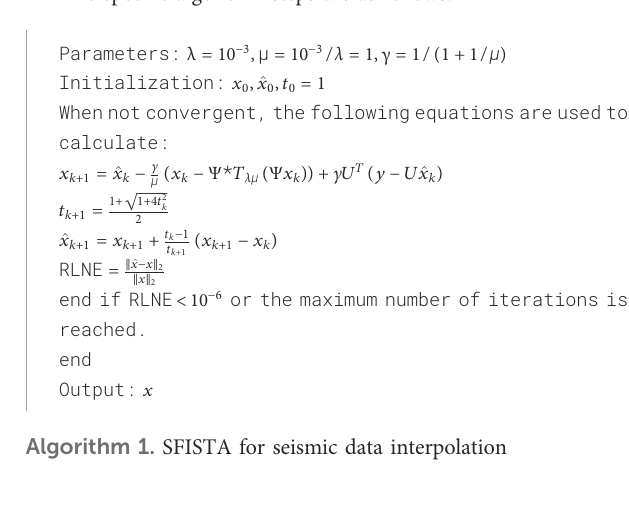
Algorithm 1. SFISTA for seismic data interpolation